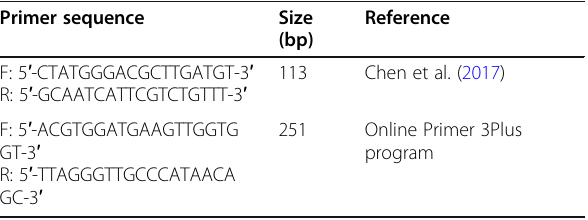
Table 2 Primer for quantitative real-time polymerase chain reaction (qRT-PCR) used in the study Primer sequence Size (bp)